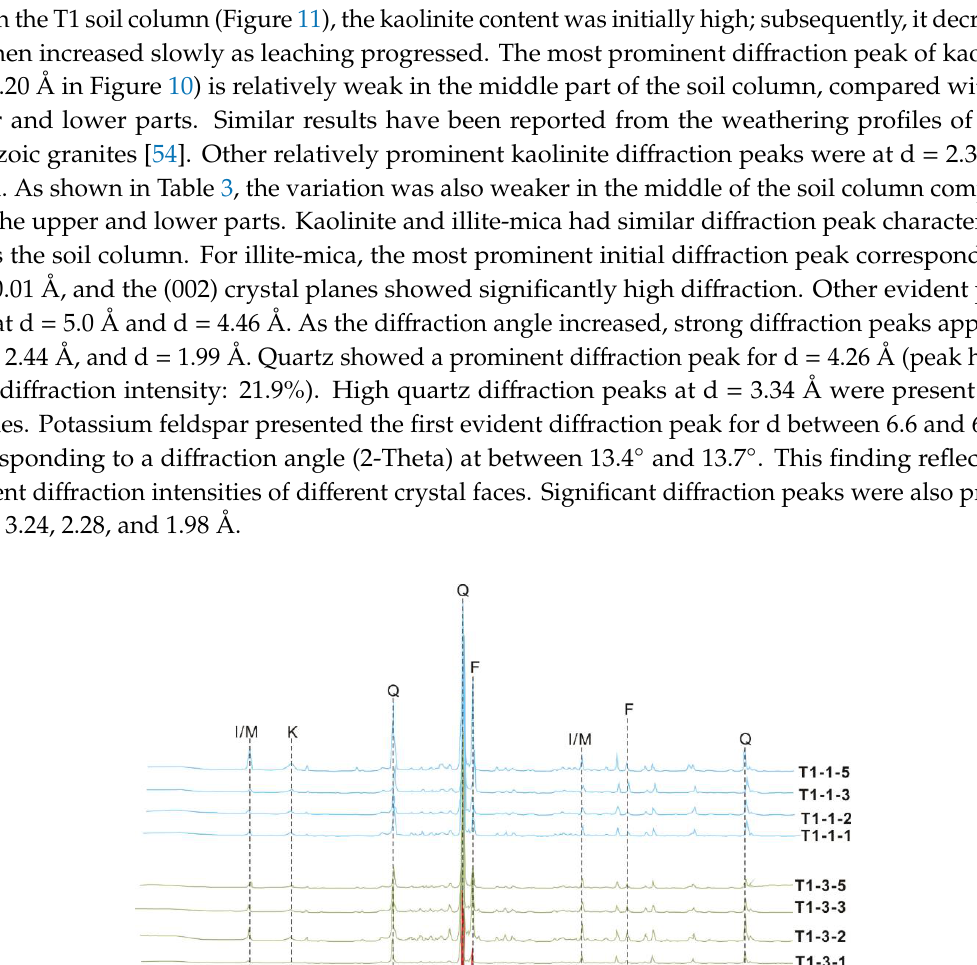
Figure 11. XRD spectra of randomly oriented bulk samples from Soil Column T1 (simulated leaching). I/M: illite-mica; K: kaolinite; Q: quartz; F: potassium feldspars.